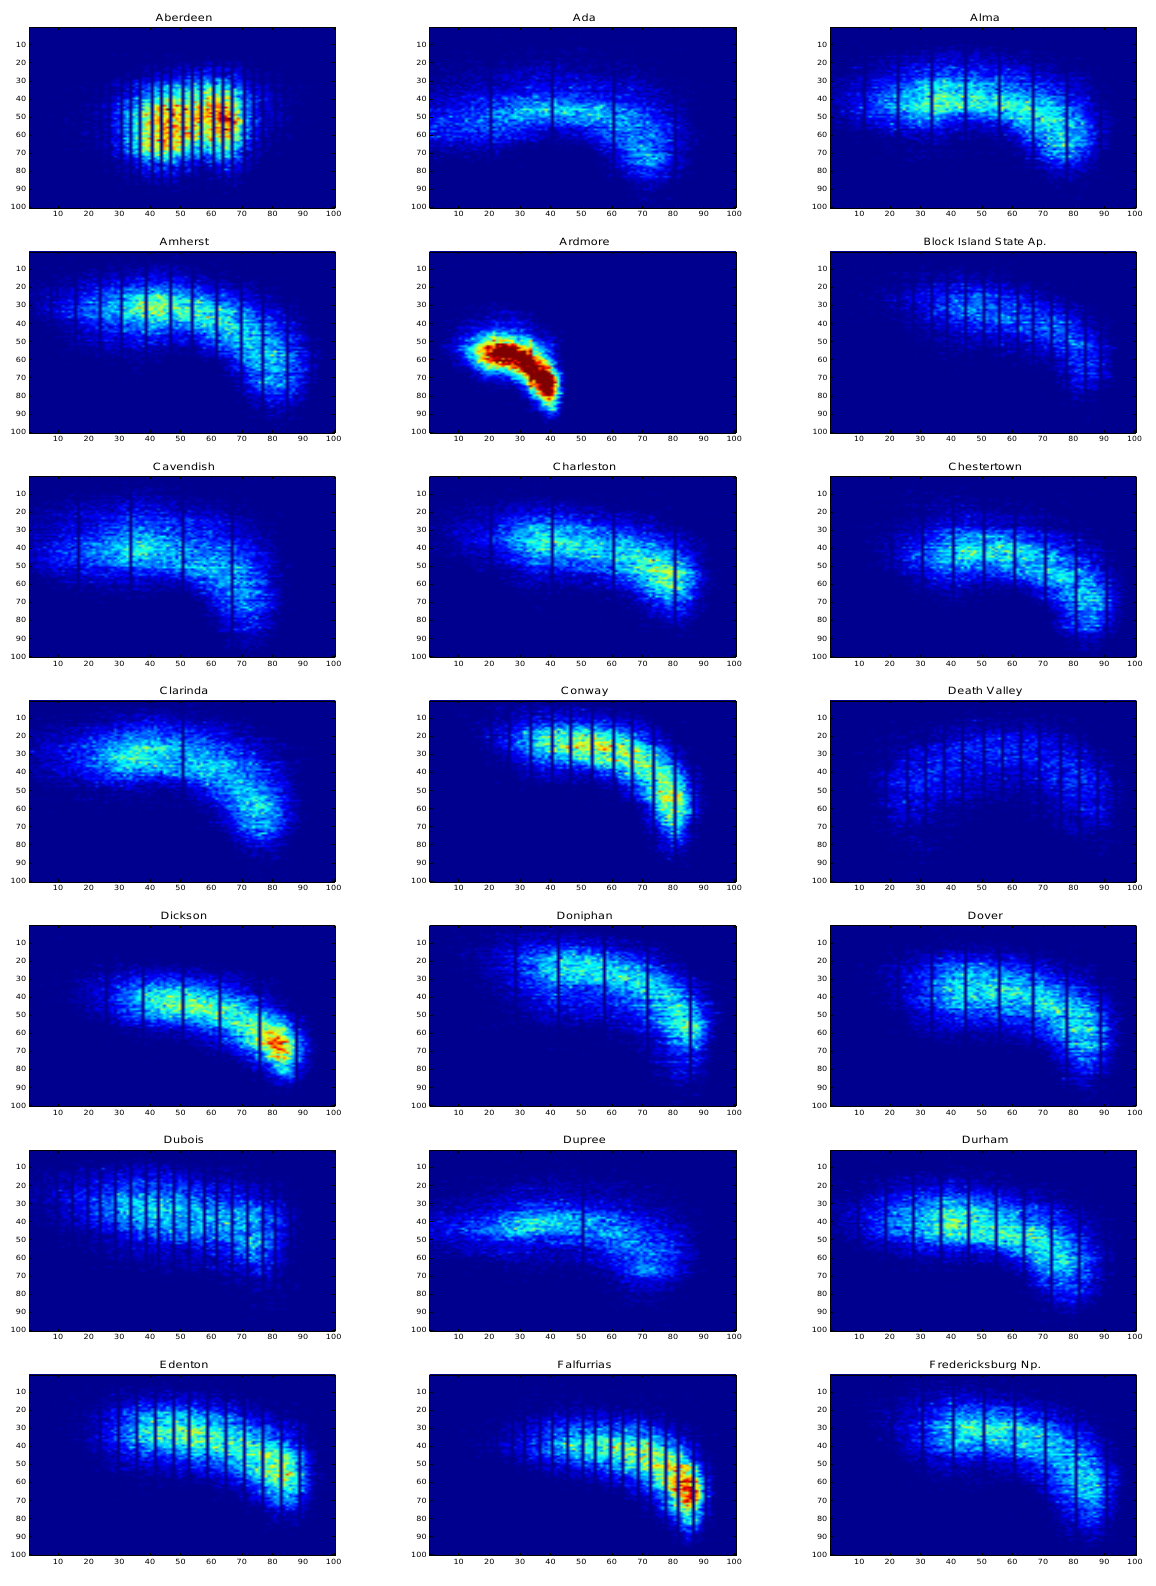
Fig. 13. Phase planes for 42 sites across the USA. All study sites are listed in Appendix. www.nonlin-processes-geophys.net/20/643/2013/ Nonlin. Processes Geophys., 20, 643–655,